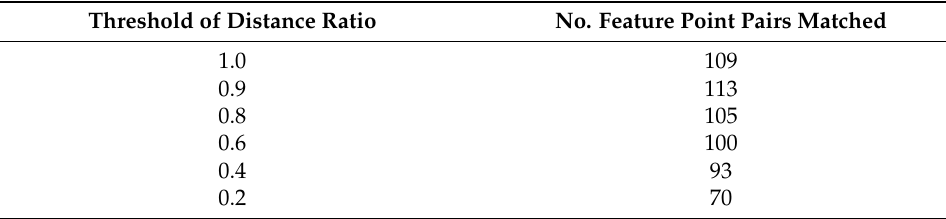
Table 1. Image matching quality evaluation.